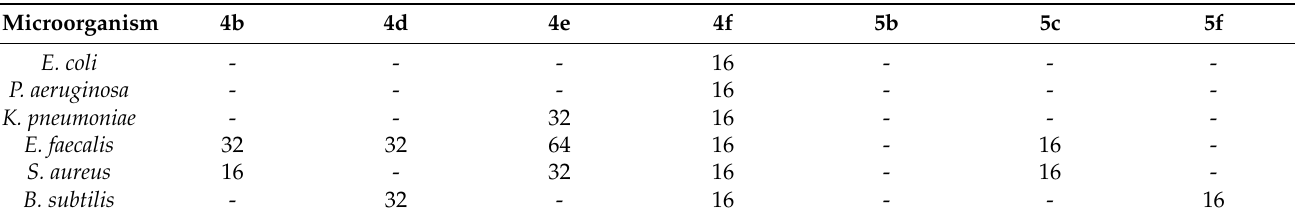
Table 4. MBC to MIC ratios calculated for the compounds showing an antibacterial activity in the dark conditions.